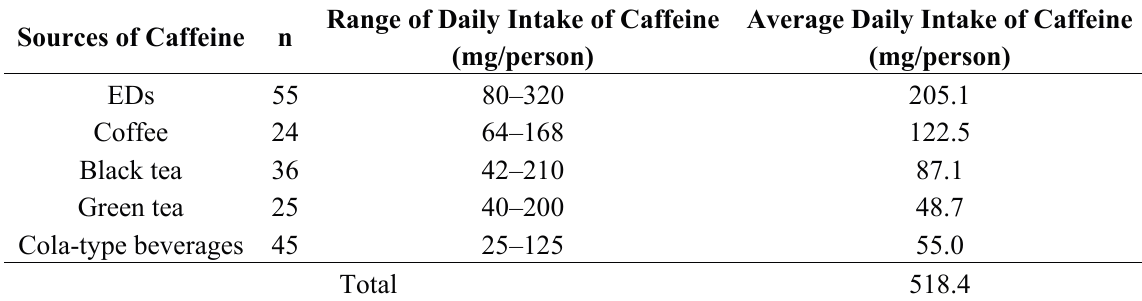
Table 6. Caffeine intake in the subgroup of adolescents who consume EDs every